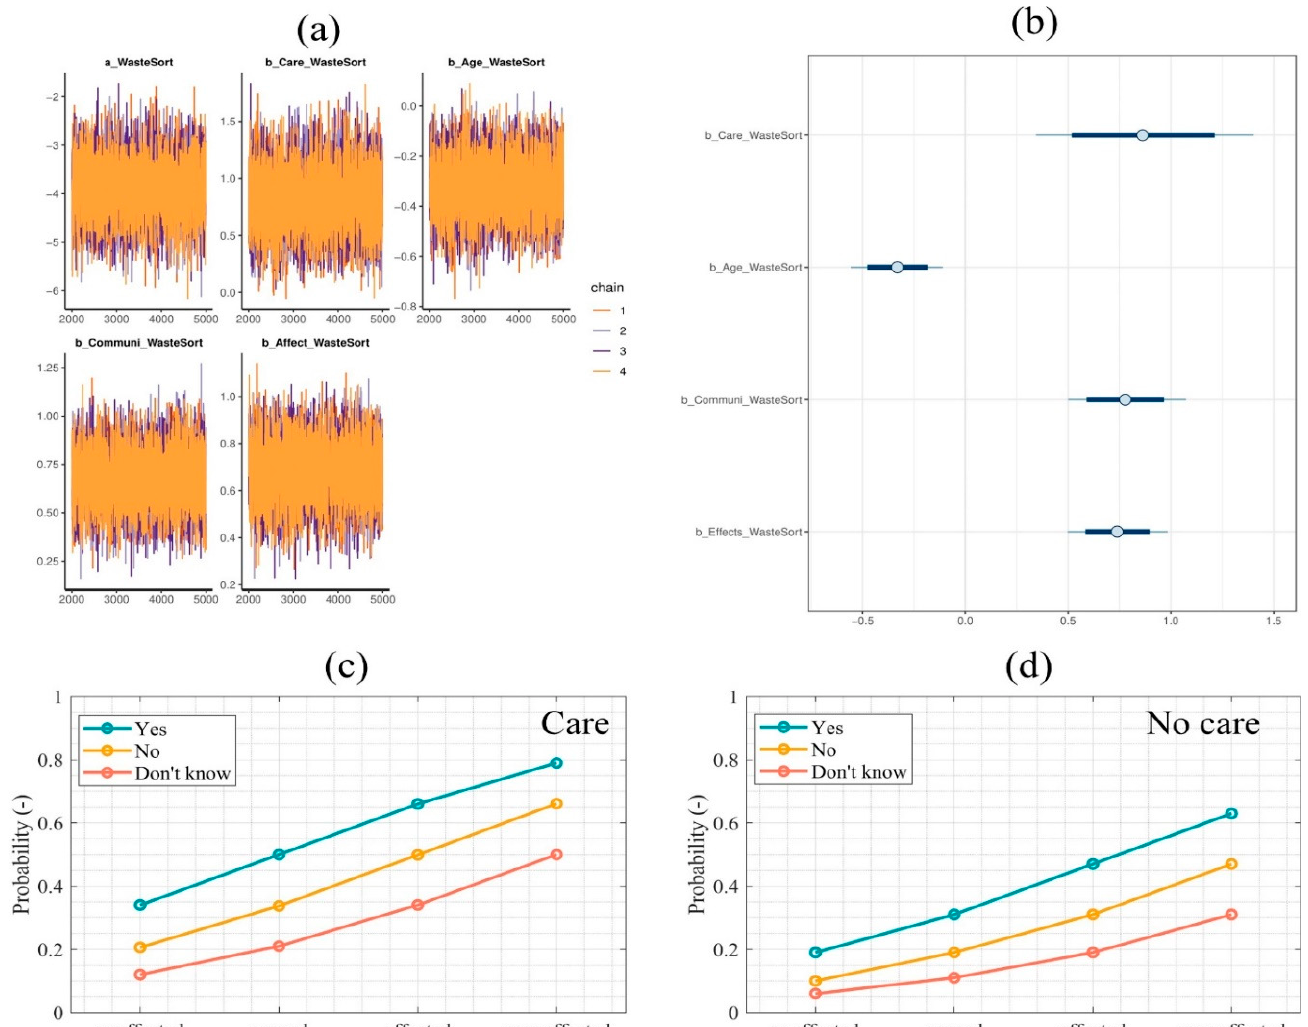
Figure 3. Trace plots for Model 1’s posterior parameters ( a ), distribution of posterior coefficients estimated with uninformative priors ( b ), probabilities of sorting waste based on communication levels and perceived effects of household group with care ( c ) and no care ( d ).